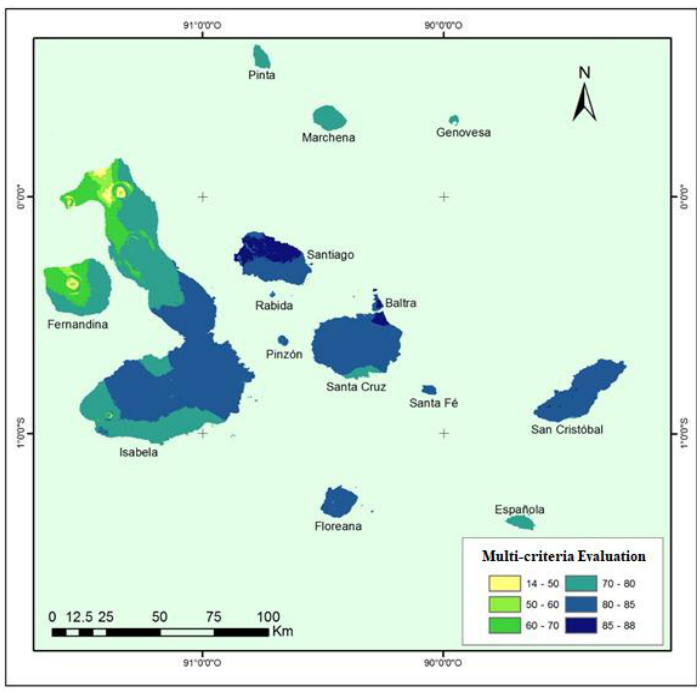
Figure 4. Multicriteria Evaluation for location selection of wind energy.